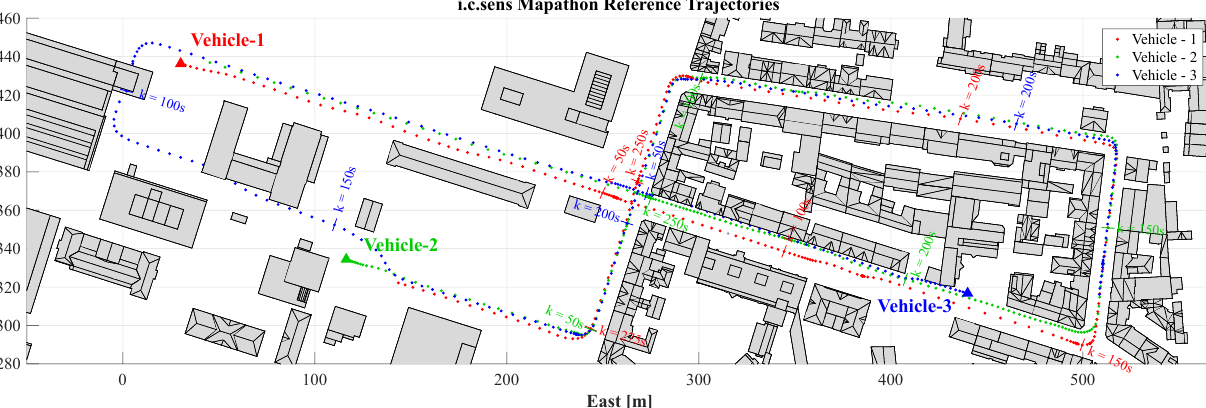
Figure 2. Representation of the three trajectories and the 3D building model. The triangles represent the starting point for the vehicles. obtained from a GNSS receiver by measuring the pseudo- range and the Doppler range rate at any epoch k (Hofmann- Wellenhof et al., 2008). If multiple vehicles measures the carrier phase from the same satellite, baselines between the vehicles can be computed (V2V